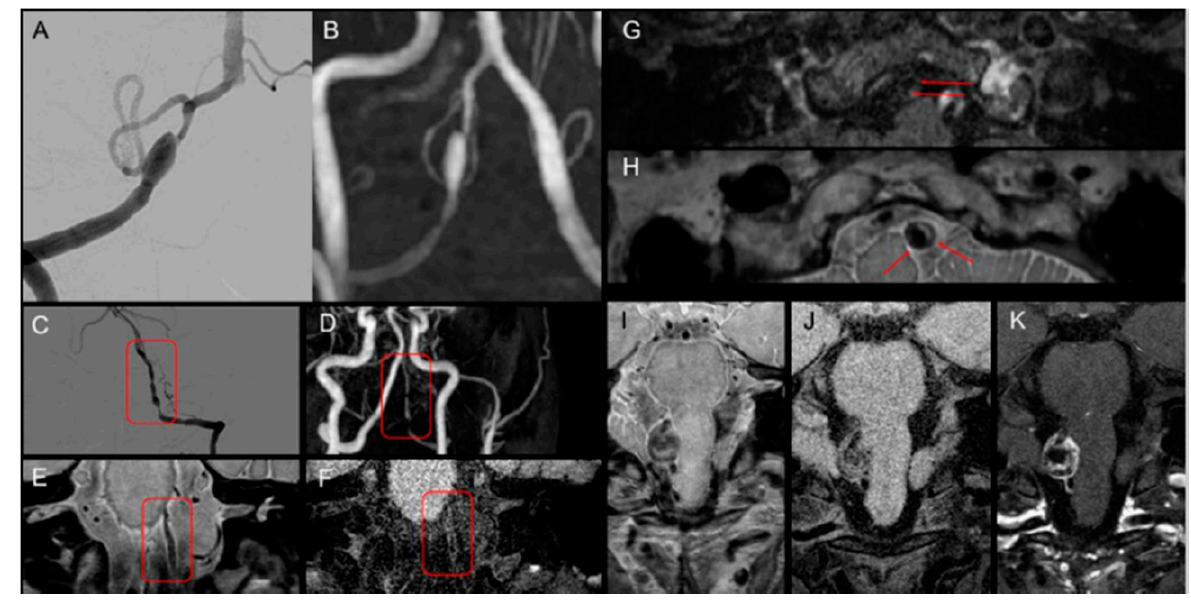
Figure 3. Radiographic features of vertebral artery dissection. ( A , B ) Fusiform dilatation in DSA and MRA. ( C – F ) Stenosis with dilatation called a string of pearls signs in DSA and HR-VWI. ( G , H ) Double-lumen sign in HR-VWI. ( I – K ) Dissecting aneurysm in HR-VWI. Abbreviations: DSA, digital